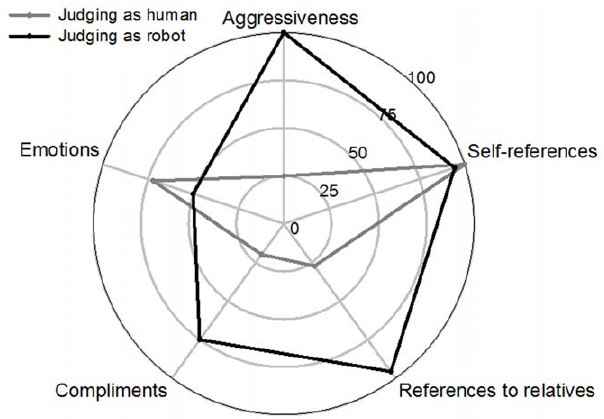
Figure 3. Patterns of behavioral expressiveness of the judges whether they perceived their communication partners as humans or as robots. Patterns are based on the judges’ results on the five dimensions selected (aggressiveness, self-references, references to relatives, compliments, emotions). Note that the two patterns are significantly different ( p , .05, Kolmogorov-Smirnov